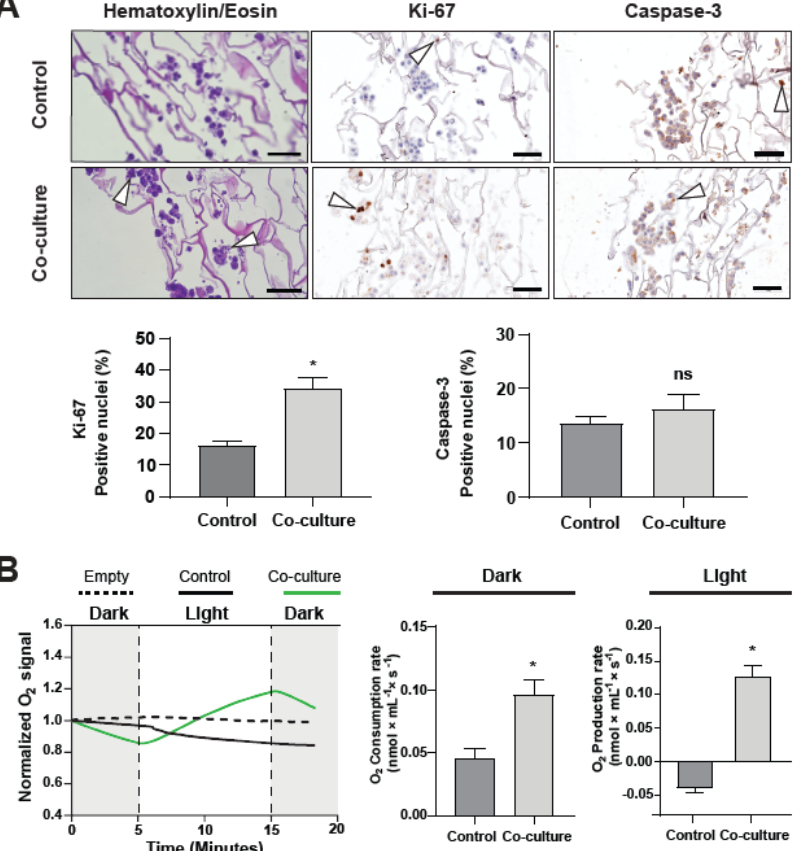
Figure 7. Characterization of a photosynthetic tumor model. Microalgae were seeded into scaffolds with grown tumors and incubated for two hours under physiological conditions. A histologic analysis of the scaffolds was conducted by staining tumor cells with Hematoxylin/Eosin against Ki-67 and Caspase-3. Arrowheads indicate the presence of microalgae clusters (H/E) and positive nuclei for the corresponding stain (Ki-67 and Caspase-3). Ki-67 quantification ( A , lower left ) shows a significant increase in tumor cell proliferation when microalgae are present, while Caspase-3 quantification ( A , lower right ) shows no significant differences were detected. Oxygraphic studies of co-cultured scaffolds show that, in darkness ( B , middle ), co-cultured scaffolds consume twice as much oxygen as control scaffolds. Under light ( B , right ), control (C32) scaffolds keep consuming oxygen, while co-cultured scaffolds produce over twice the consumed amount of oxygen. All assays were performed in at least three independent experiments and data are presented as average + SE. Scale bars in ( A ) represent 100 µm. In all experiments, p ≤ 0.05 was considered as significant using a Mann–Whitney test. * = p ≤ 0.05 , ns = not significant